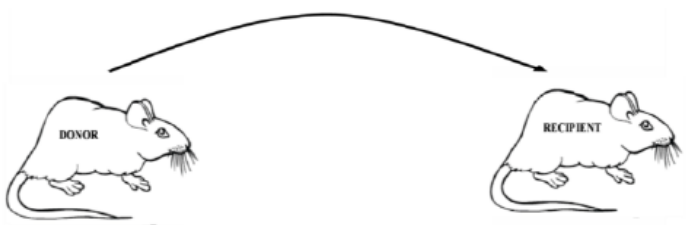
Figure 2. AIT by initiating/maintaining non-pathogenic IgM ab response against the autoimmune disorder causing nephritogenic aags for the termination of the autoimmune disease. The increased levels of rat nephritogenic IgM aabs neutralize both circulating disease maintaining modified ag and disease contributing native aag. Disease process is terminated and tolerance to self is re-established. Abbreviations: aab, autoantibody; aag, autoantigen; AIT, antibody information transfer; ab, antibody; ag, antigen; IC, immune complex; IgM, immunoglobulin M; IP, intraperitoneal.